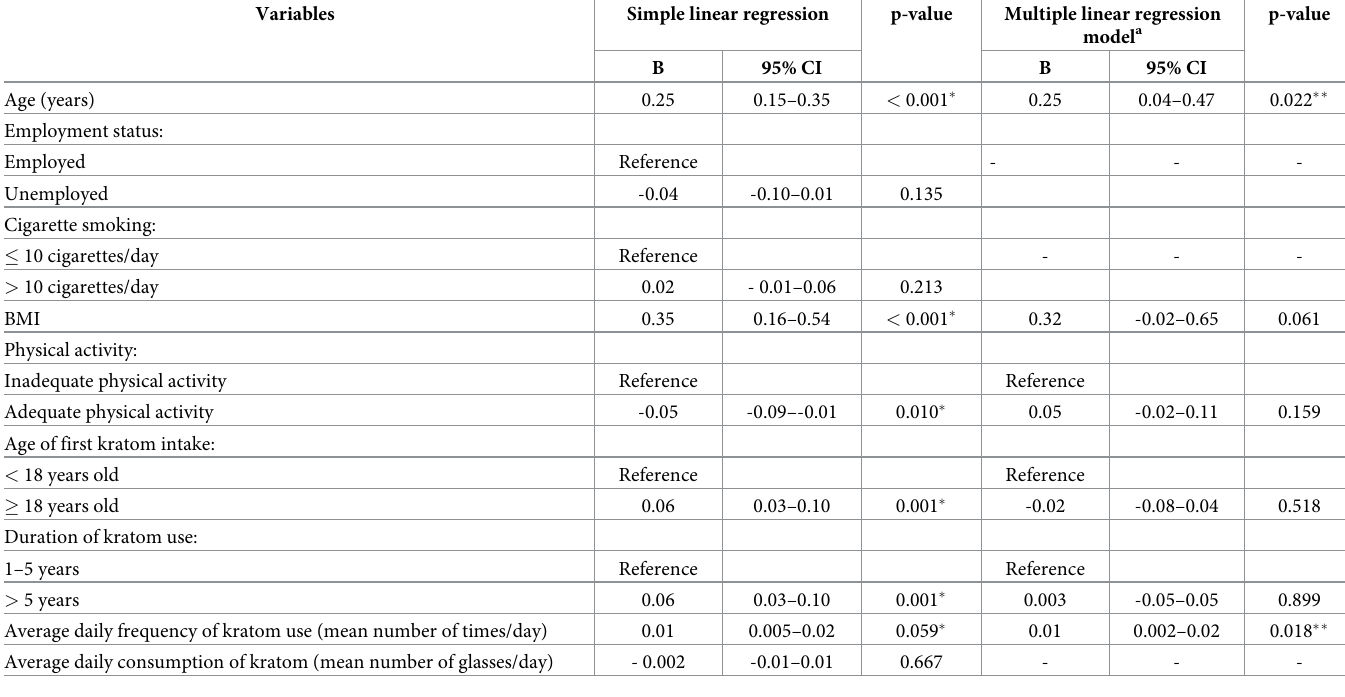
Table 5. Association between kratom use characteristics and serum total cholesterol level among kratom users, accounting for confounding factors such as age, employment status, cigarette smoking, physical activity, and